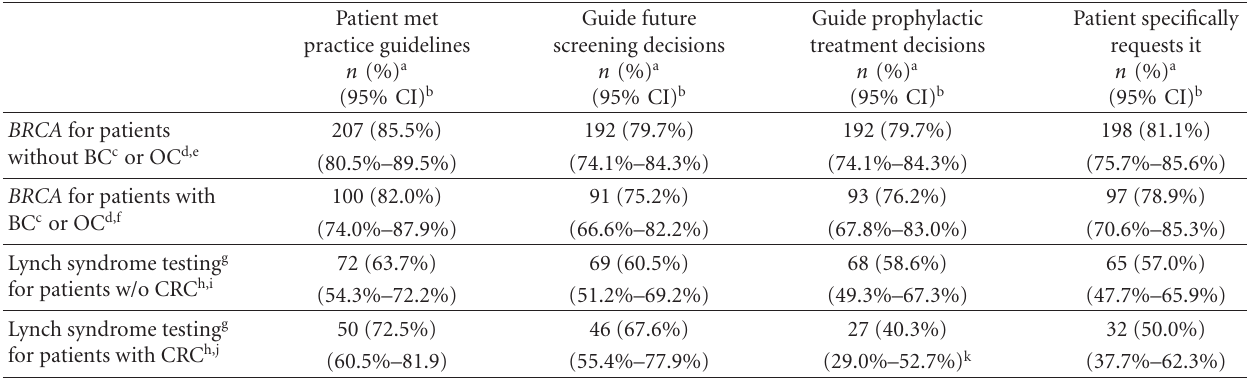
Table 5: Reasons why clinicians reported ordering specific cancer genomics tests in the past 12 months , among clinicians who ordered the genetic